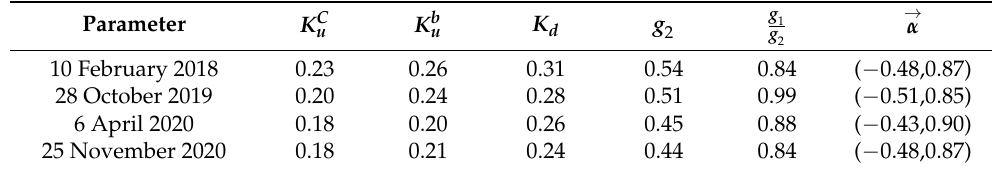
Table 6. Water depth